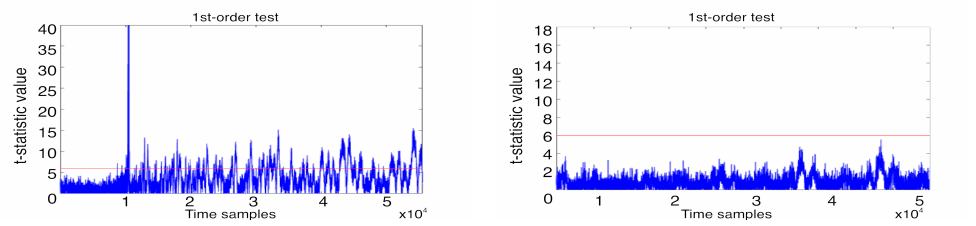
Figure 20: rdm_point_new_curve ()rdm vs fixed point